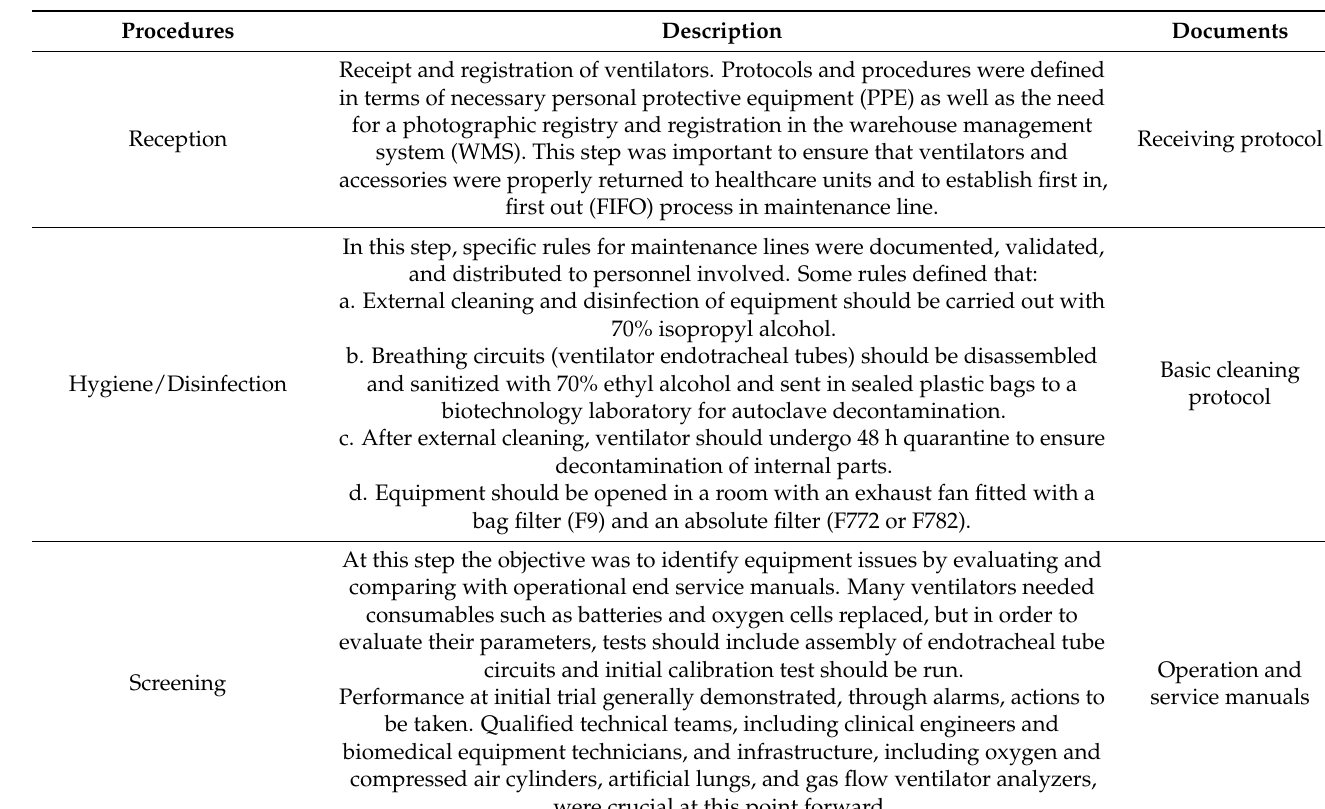
Table 1. Steps and procedures developed by Reference